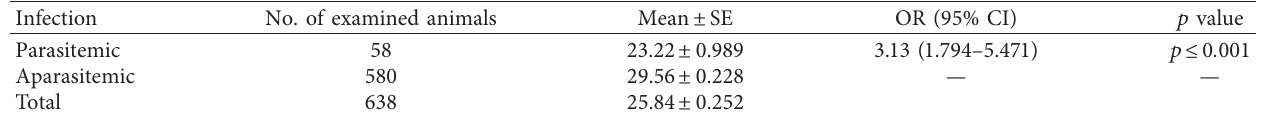
Table 6: Mean PCV value of parasitemic and aparasitemic